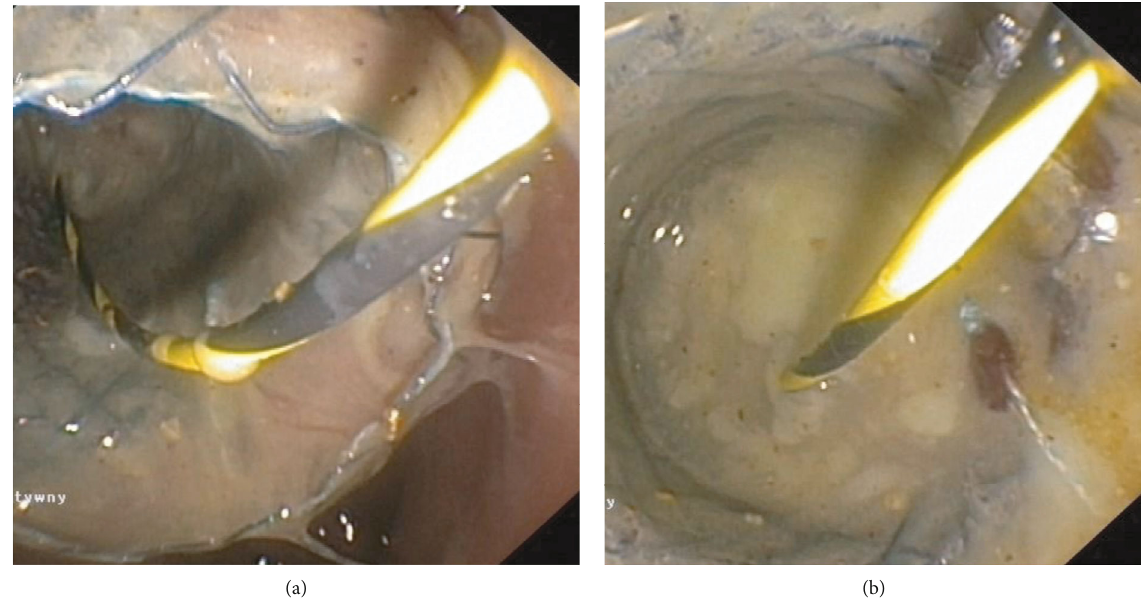
Figure 8: (a, b) Single transluminal gateway technique using LAMS for infected pancreatic pseudocyst treatment. Table 1: Characteristics of the patients with PPFCs. Table 2: Indications for endoscopic treatment of All patients